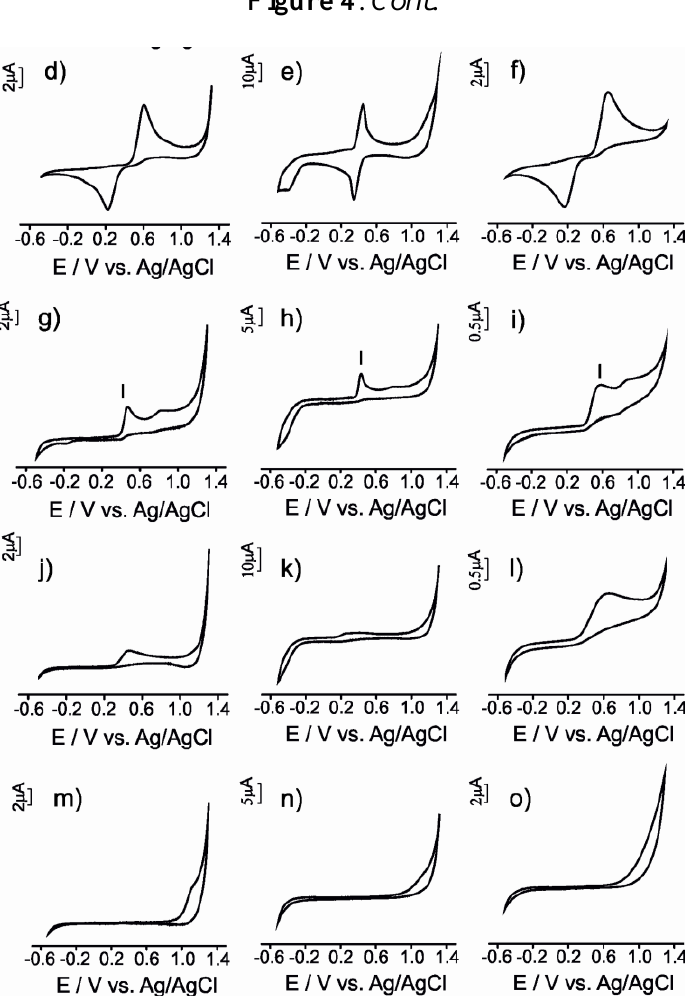
Table 1. Electrochemical parameters obtained from the responses of the CPEs